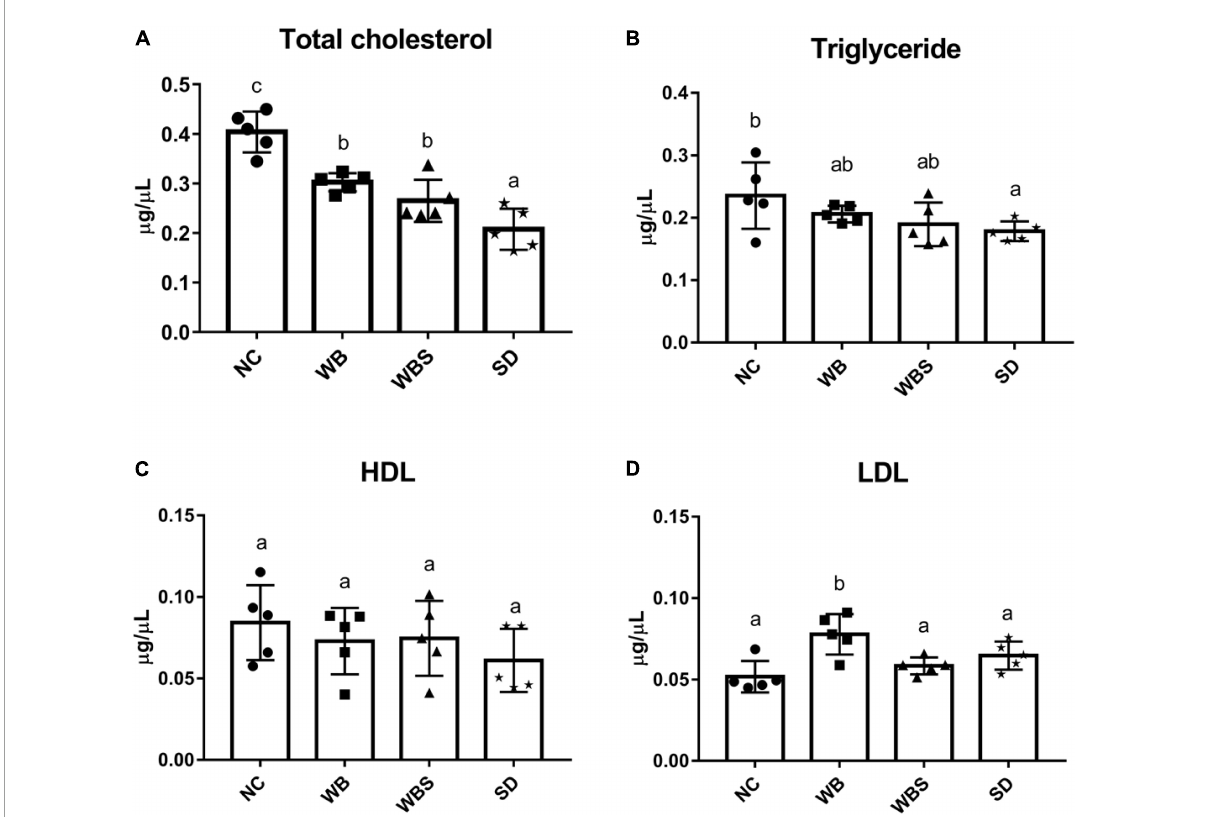
FIGURE4 Cholesterol assay in mouse blood serum of all groups. (A) Total cholesterol assay. (B) Triglyceride assay. (C) High-density lipoprotein (HDL) assay. (D) Low-density lipoprotein (LDL) assay. Error bars present the standard deviations of five replicates ( n = 5 male mice). One-way ANOVA followed by Duncan’s post-hoc analysis, and bars with different letters indicate significant differences at p < 0.05.